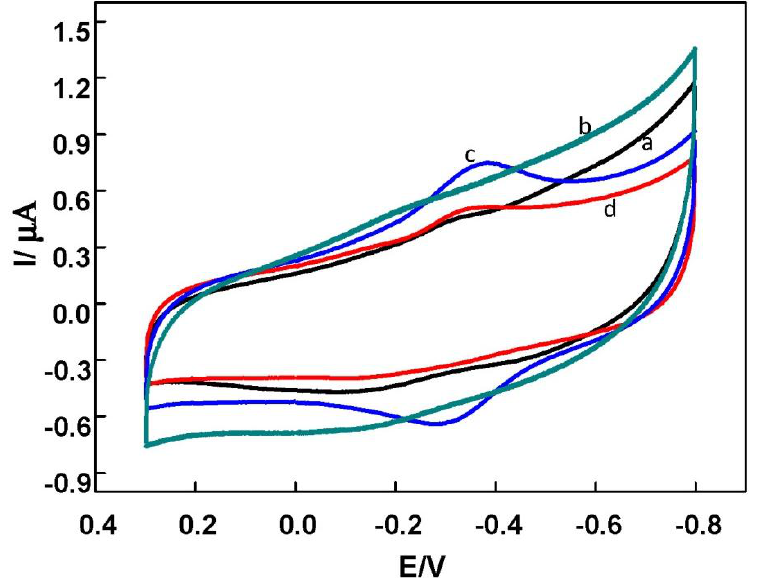
Figure 3. Cyclic voltammograms (CVs) of the different modified GC electrodes in N 2